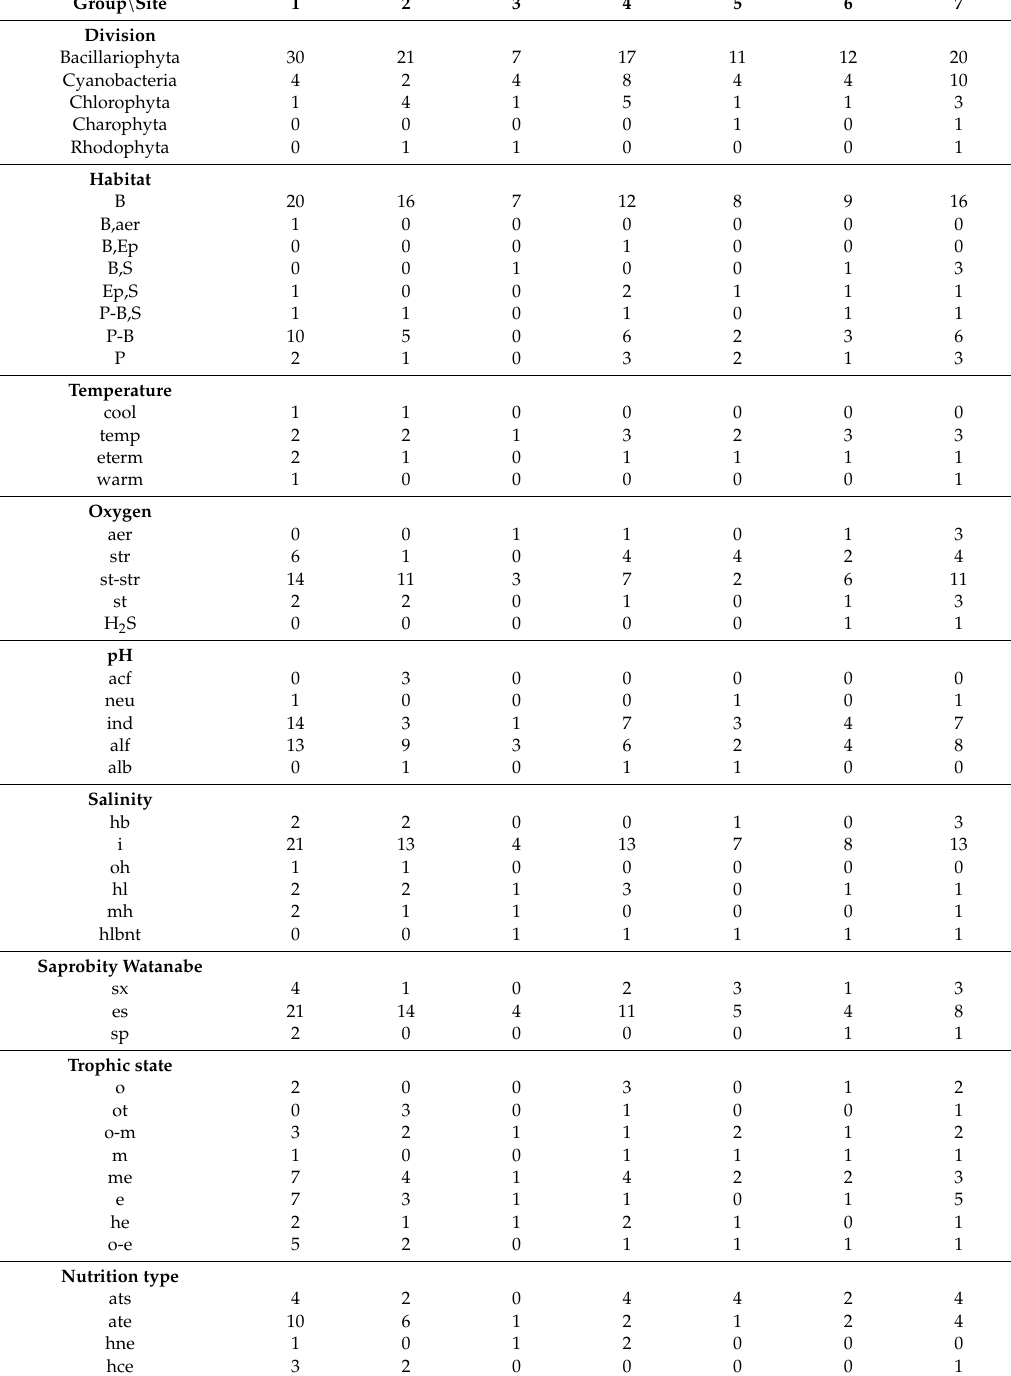
Table 4. Calculation of species in taxonomic and bioindicator groups, total species number and index saprobity S over sites of the Abraham Lincoln Birthplace National Historical Park. Group \ Site 1 Division Bacillariophyta